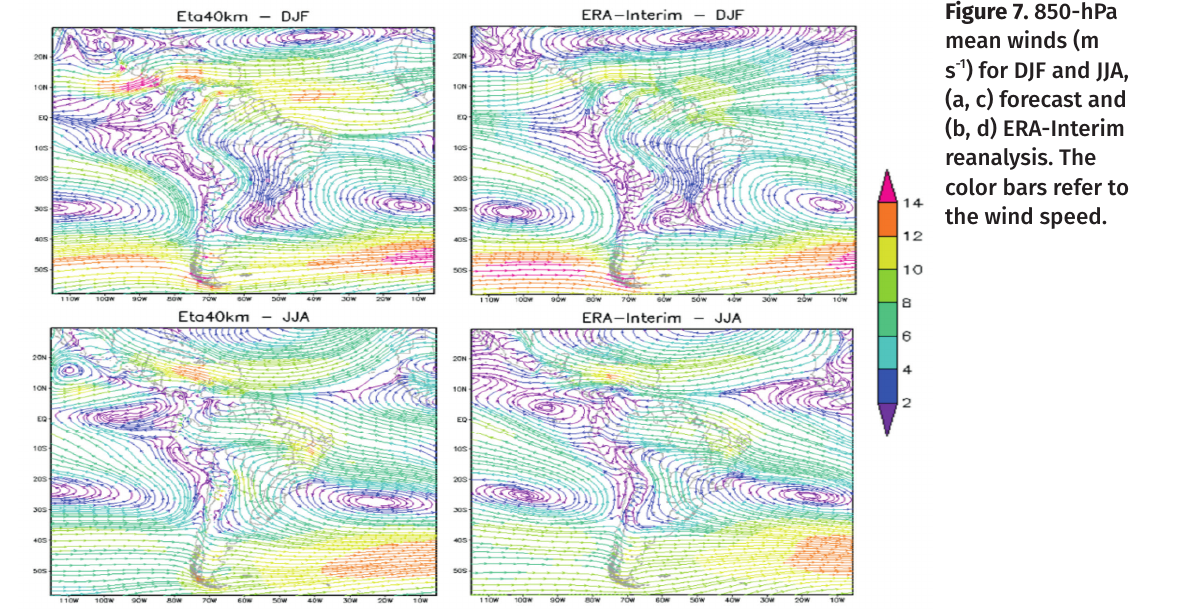
Figure 7. 850-hPa mean winds (m s -1 ) for DJF and JJA, (a, c) forecast and (b, d) ERA-Interim reanalysis. The color bars refer to the wind